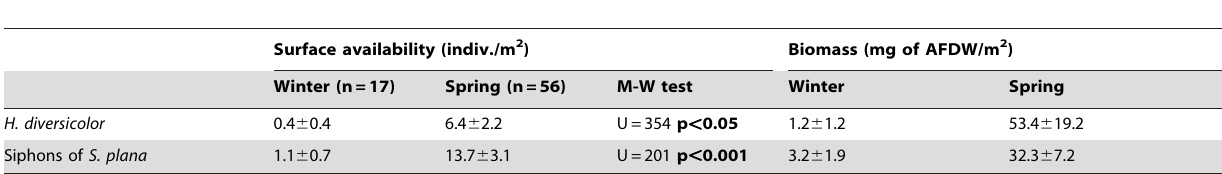
Table 4. Seasonal variations in the surface availability of Hediste diversicolor and siphons of Scrobicularia plana and their corresponding biomass.